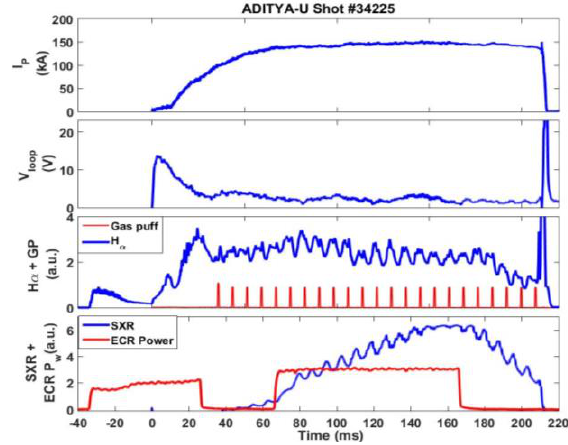
Fig. 2. ECRH two pulse in Aditya-U